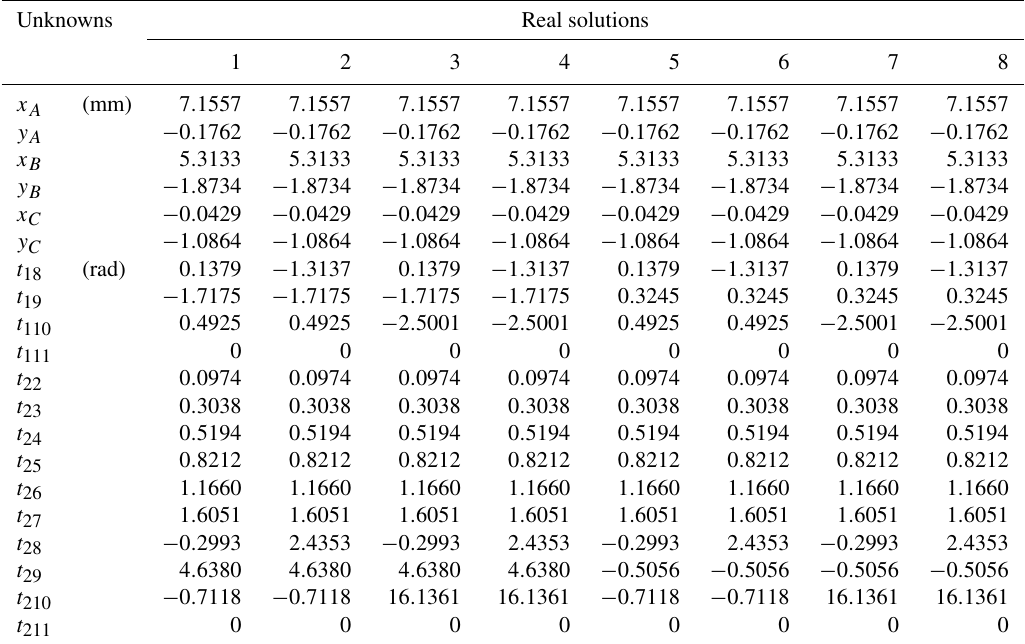
Table A6. Real solutions